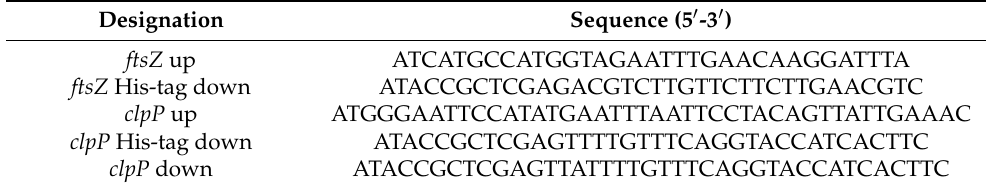
Table 1. The primers used in this